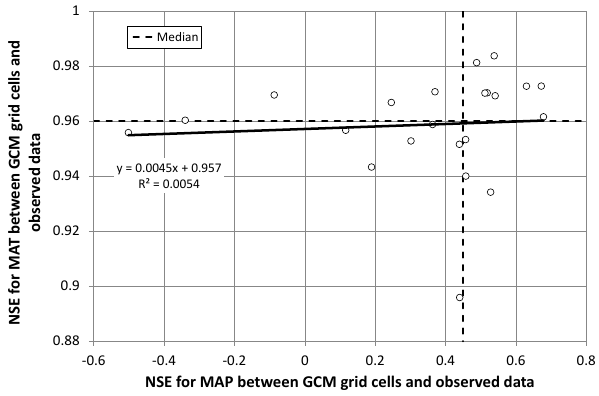
Figure 7. Comparison of Nash–Sutcliffe efficiency (NSE) values between CMIP3 GCM and observed mean annual temperatures with NSE values between CMIP3 GCM and observed mean annual